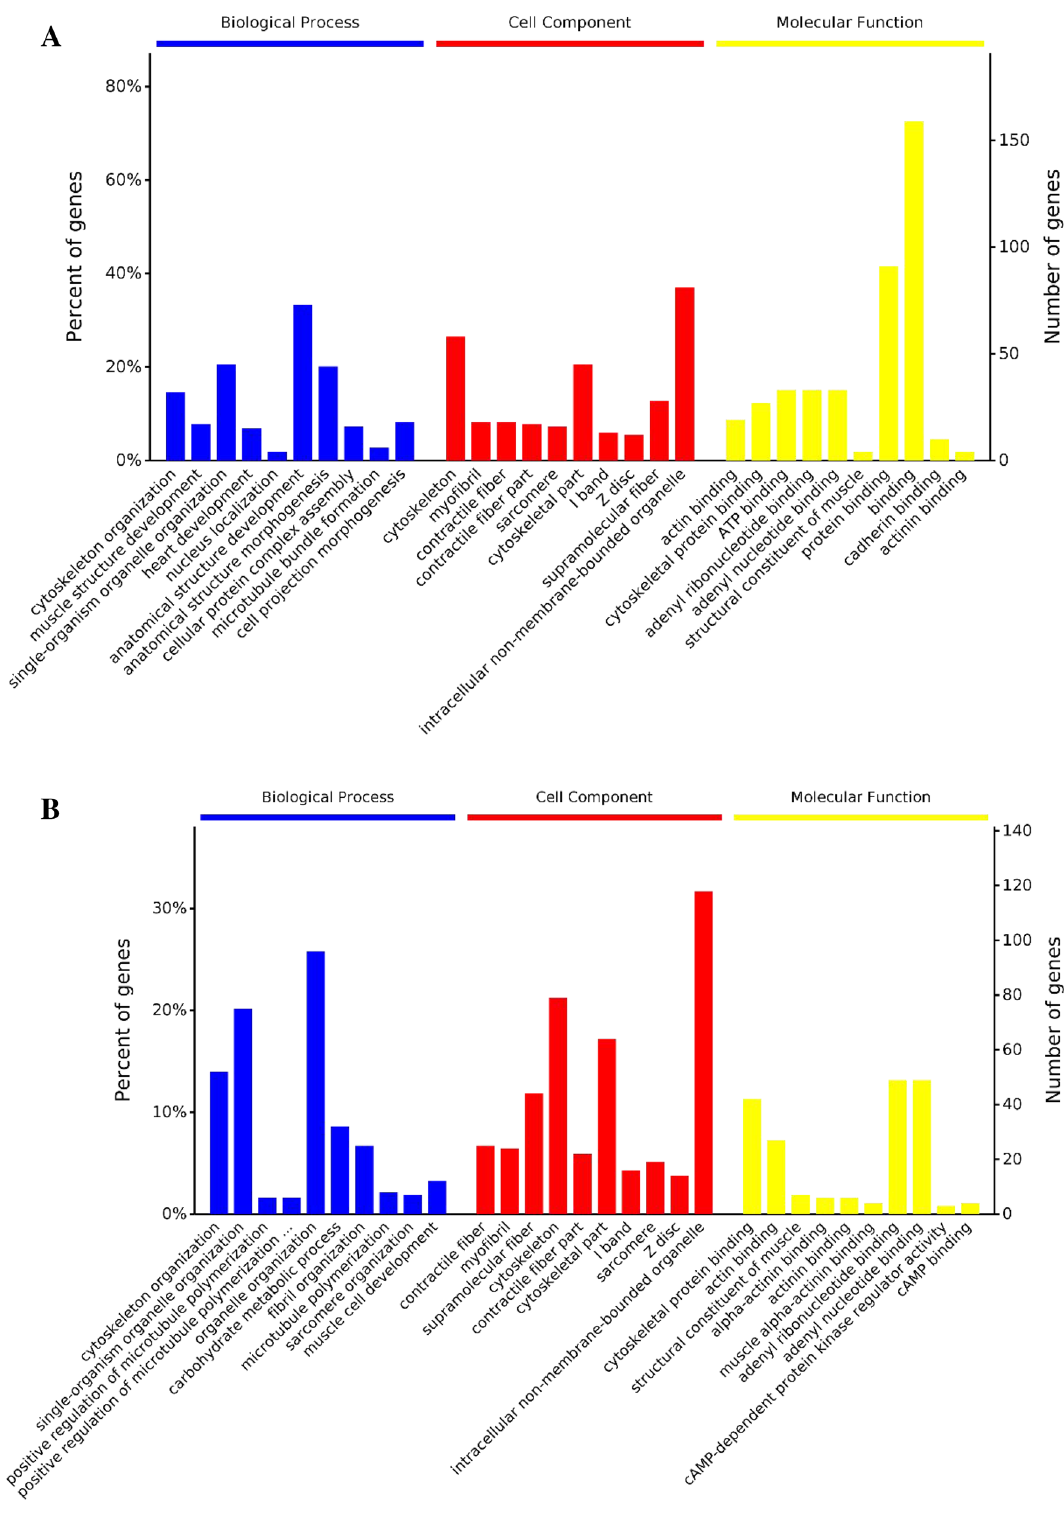
Figure 1. ( A ) A comparison of functional classification of identified phosphoproteins at 12 h. ( B ) A comparison of functional classification of identified phosphoproteins at 72